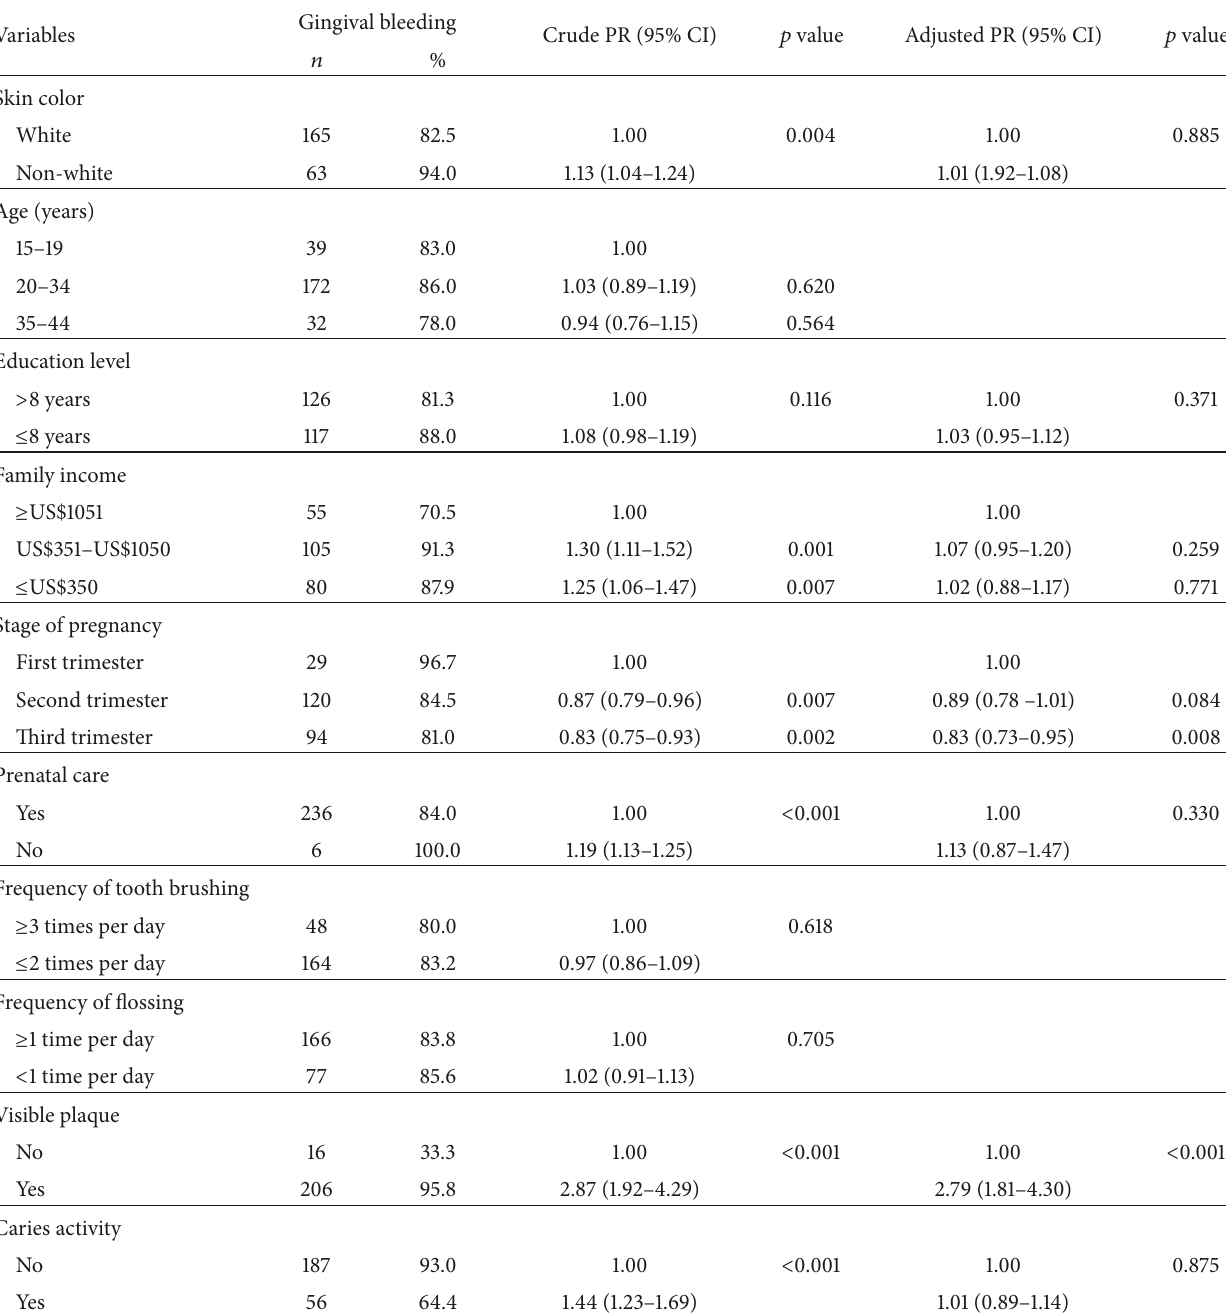
Table 3: Crude and adjusted analysis [prevalence ratio (PR)] for the association between independent variables and dental gingival bleeding in pregnant